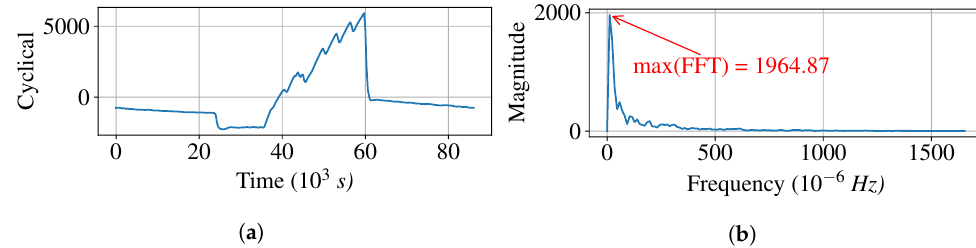
Figure 11. CO 2 concentration cyclical component. ( a ) Time domain; ( b ) frequency